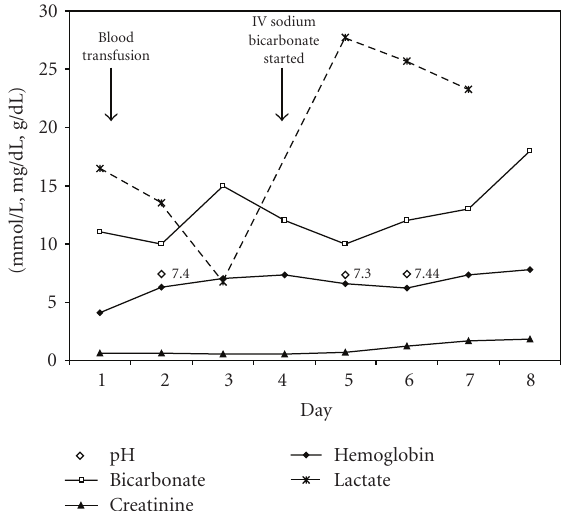
Figure 3: Correlation between lactate level, pH, bicarbonate, creatinine, and